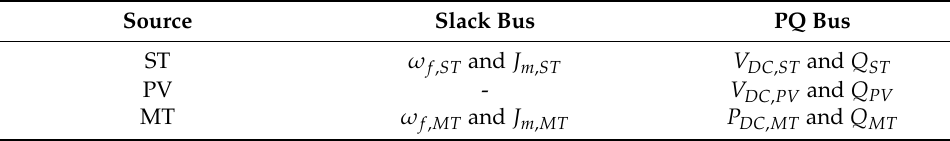
Table 1. Control